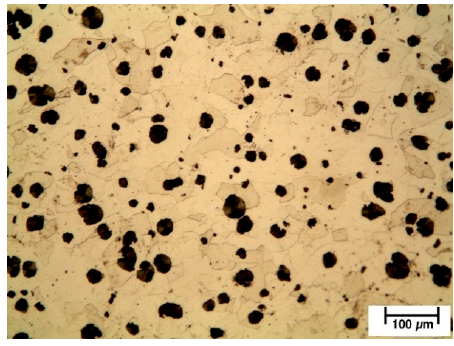
Figure 9. High strength DCI base material without etching (magnification 200×).